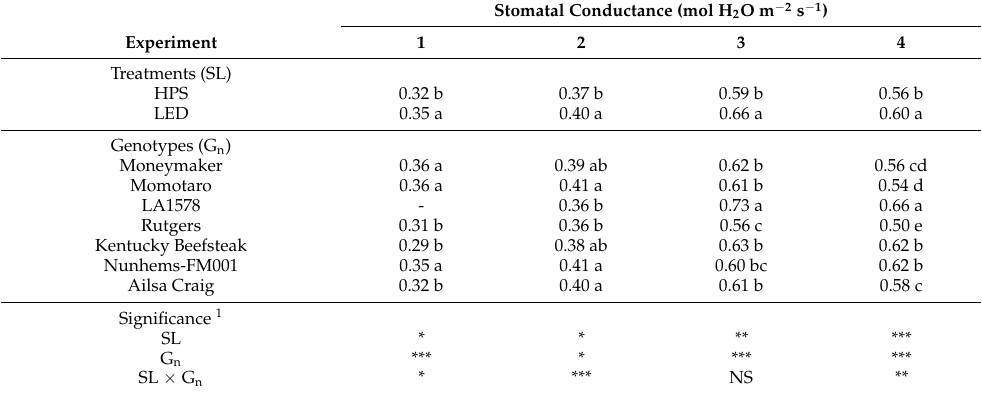
Table 1. Stomatal conductance (measured using a porometer) in seven tomato genotypes grown under HPS and LED supplemental light, in four experiments differing in fraction of SL over natural light (treatments: n = 21; genotypes: n = 3). Significance was tested by two-way ANOVA. Means followed by different letters within a column indicate significant differences according to Fisher’s protected LSD test ( p = 0.05). SL—supplemental light treatments; Gn—genotypes ; SL × Gn—interaction between SL and G n